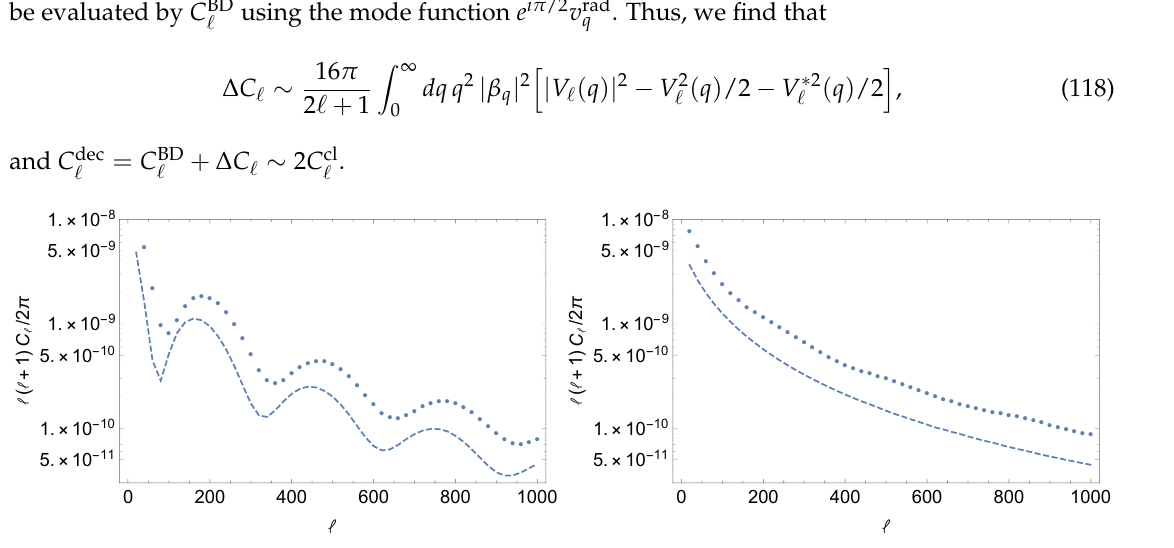
Figure 6. Left panel: C BD line) and C dec (cid:96) (dotted line) with (cid:101) = 1.5.